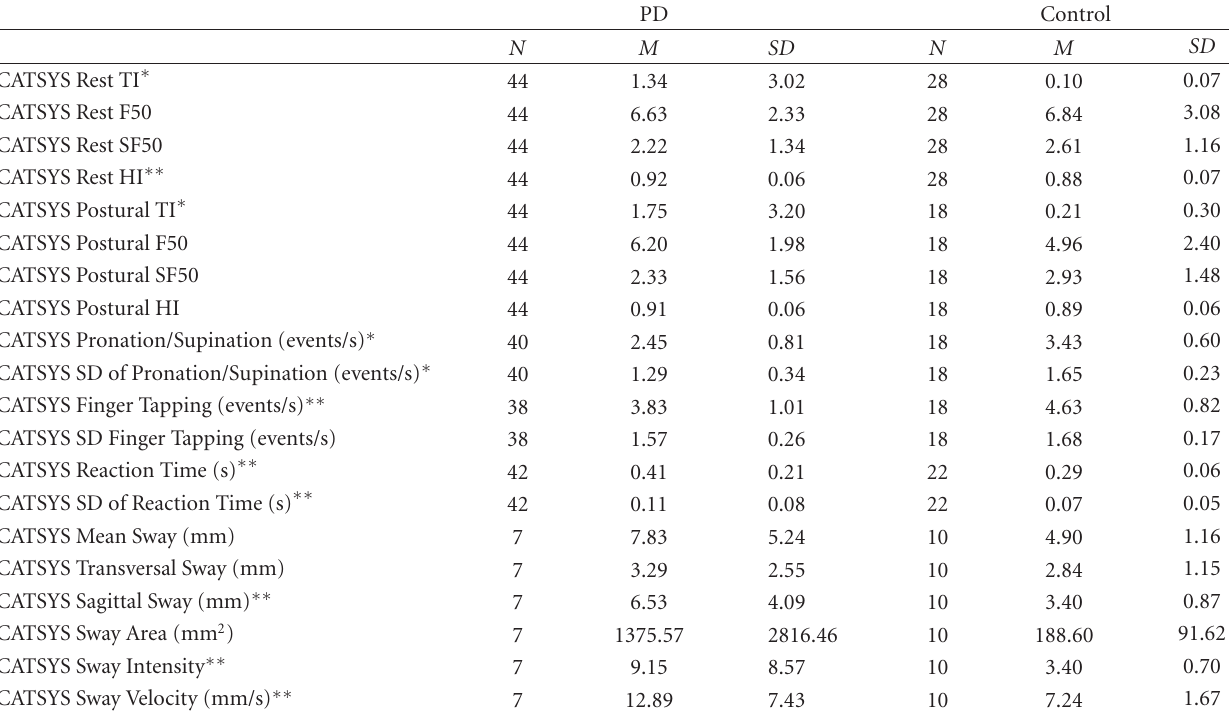
Table 2: CATSYS Values for PD and Control